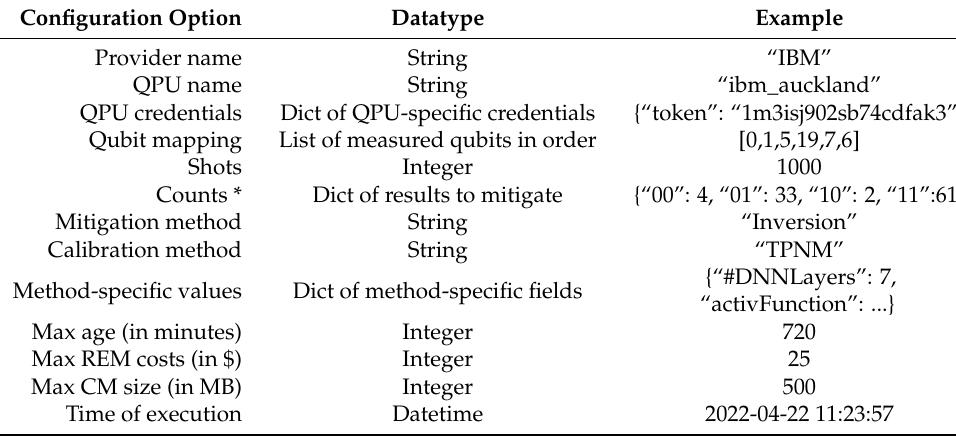
Figure 4. Overview of the REM process from a modeler’s perspective. Table 1. Overview of supported configuration